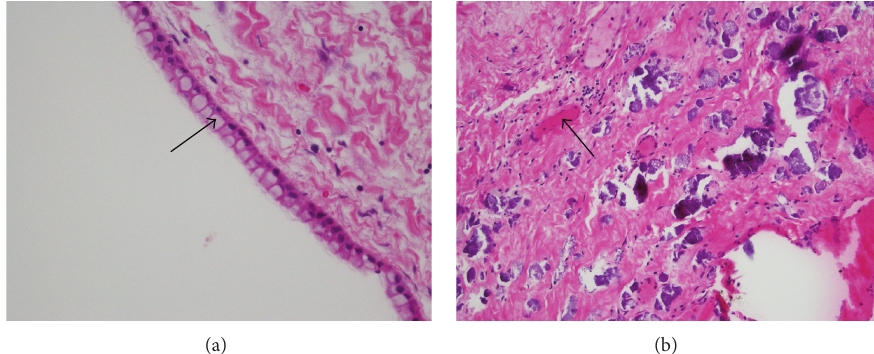
Figure 3: Light microscopy of the hematoxylin & eosin (H&E) stained tissue sections. (a) Histopathology of the enterogenous cyst showing simple columnar epithelium that is rich in goblet cells; original magnification ×400 . (b) Granulation tissue with fibroblastic and capillary proliferation; original magnification ×100